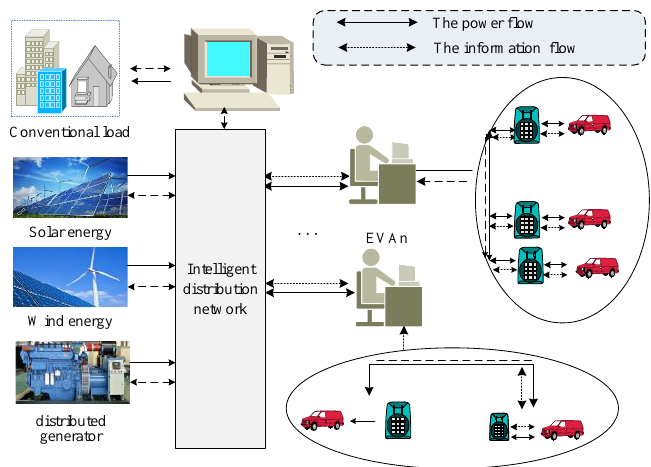
Figure 1. Schematic diagram of system structure.